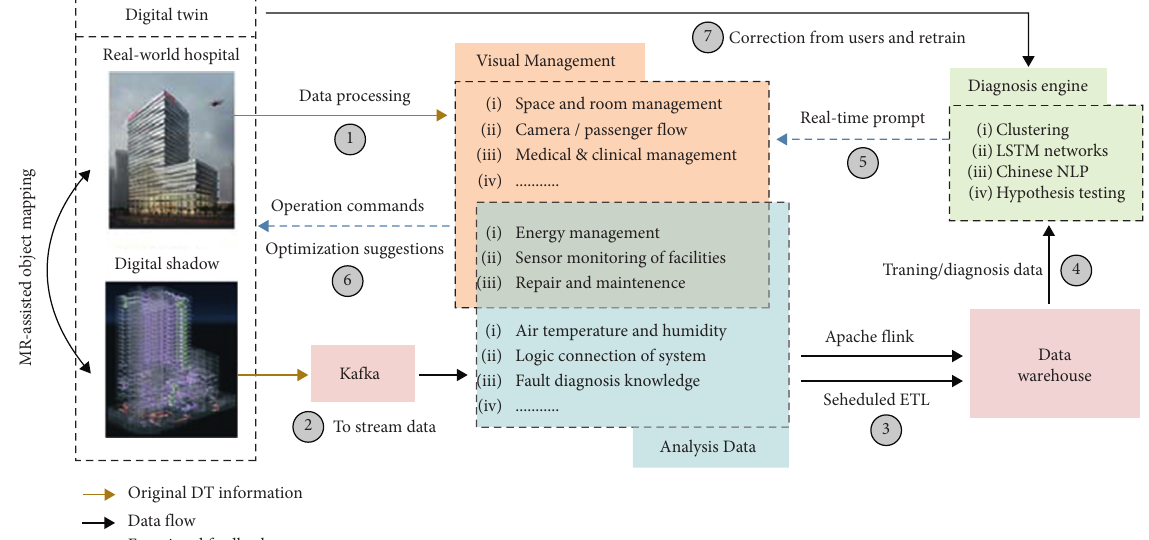
Figure 2: The operating logic of major components of the DT system.